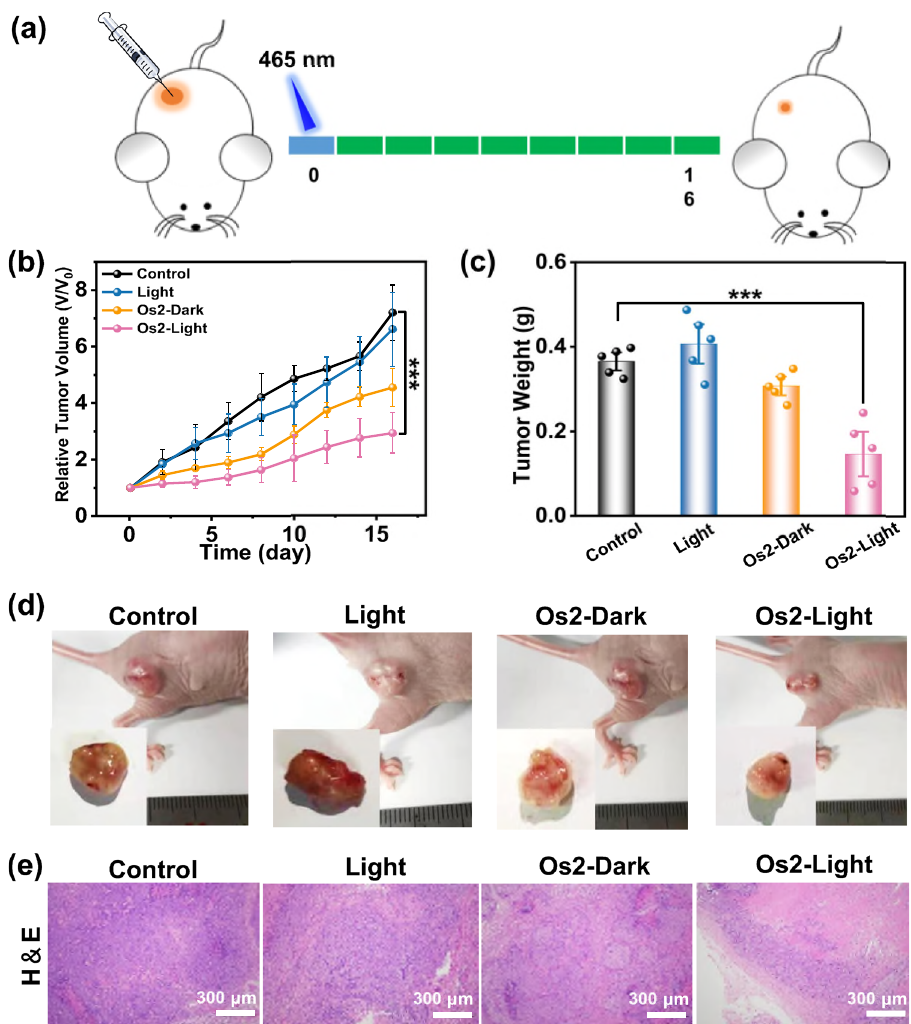
Fig. 7 In vivo photoactive chemotherapy. a Schematic of the in vivo (HeLa tumor-bearing Balb/c mice) therapeutic protocol. Mice were irradiated by light (465 nm, 13 mW/cm 2 ) for 60 min after i.t. injection with 25 μ L of PBS containing 500 μ M Os2. b Tumor growth curves after treatment. Error bars were standard errors (±SD) based on fi ve mice in each group. Statistical signi fi cance was calculated with two-tailed Student ’ s t test, p = 0.0004 (* p < 0.05, ** p ≤ 0.01 or *** p ≤ 0.001). c Tumor weights of mice at day 16 after various treatments. Error bars were standard errors (±SD) based on fi ve mice in each group. Statistical signi fi cance was calculated with two-tailed Student ’ s t test, p = 0.00042 (* p < 0.05, ** p ≤ 0.01 or *** p ≤ 0.001). d The digital photos of representative mice after various treatments. e H&E staining images of HeLa tumor tissues in mice after various treatments. The experiment was repeated three times independently with similar